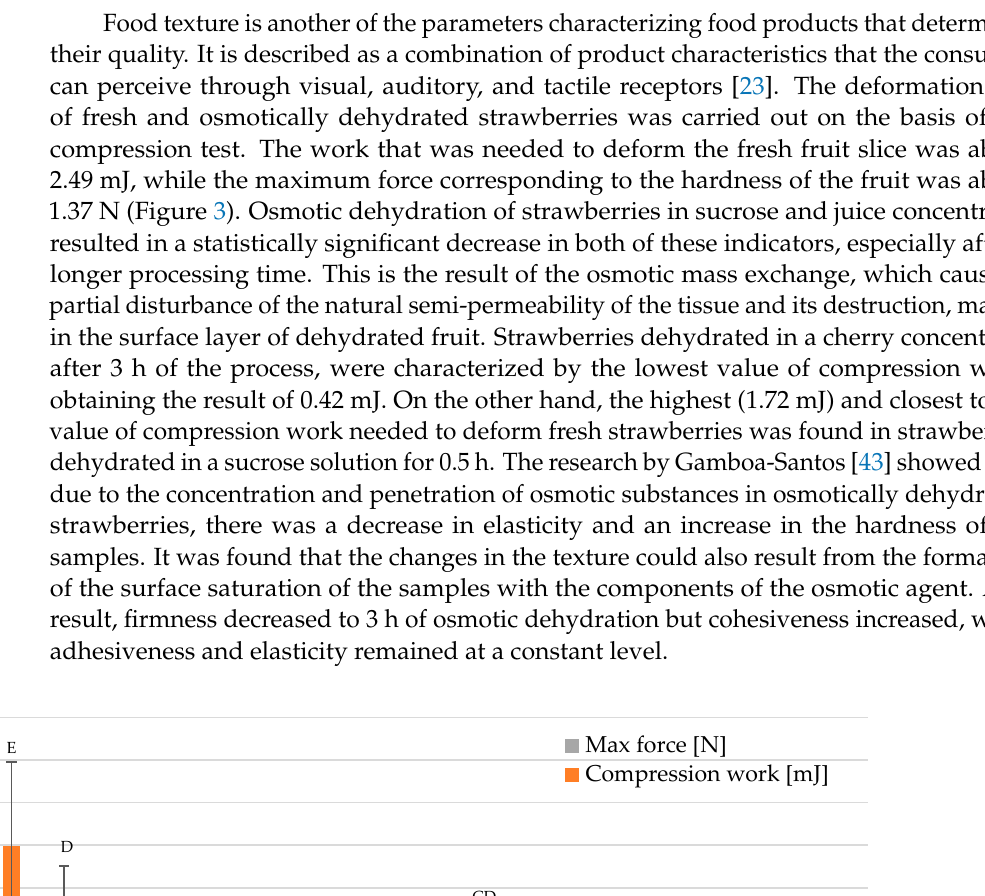
Figure 4. Microstructure (200× magnification) of fresh strawberries osmotically dehydrated for 3 h in solutions of sucrose, chokeberry (chok juice), strawberry (straw juice), and cherry juice concentrates. According to Gamboa-Santos [43], osmotic dehydration by immersion in a sucrose solution of 60° Bx at 40 °C for 4 h causes changes in texture due to the effect of changes in the water content on the pectin and cellulosic components of fruit tissues. The thin cell walls of strawberry tissue may promote damage to the cell texture and the intercellular space. Osmodehydrated samples may have detached cell walls and a damaged mid- lamella as a result of cell plasmolysis and shrinkage [45]. Changes in the shape and volume of cells and intercellular spaces are visible. This is due to the deformation and folding of the surface. It was found that the type of osmotic agent caused changes in the